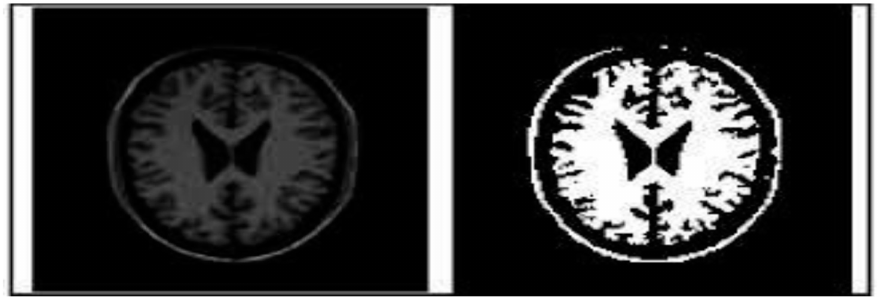
Figure 6. Thresholding Segmentation [50].